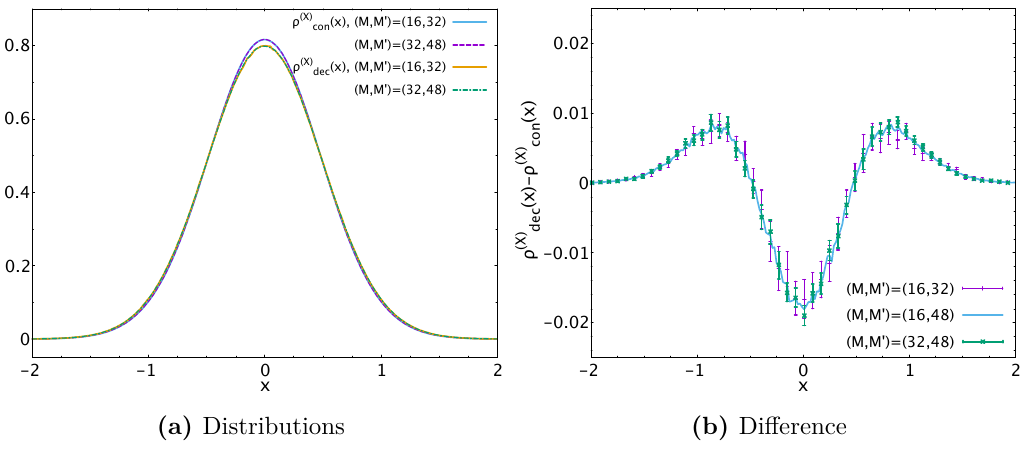
Figure 11. Yang-Mills matrix model, N = 64 , L = 24 , and T = 0 . 885 . Comparison between ρ (X) ( x ) and ρ (X) con ( x ) as shown in figure 10. (a) A small but visible difference exists between ρ (X) dec and ρ (X) con ( x ) . (b) The difference ρ (X) ( x ) − ρ (X) con ( x ) is significantly larger than the error bars of ρ (X) dec and ρ (X) con ( x ) . The error bars in each figure are obtained by jackknife analysis.